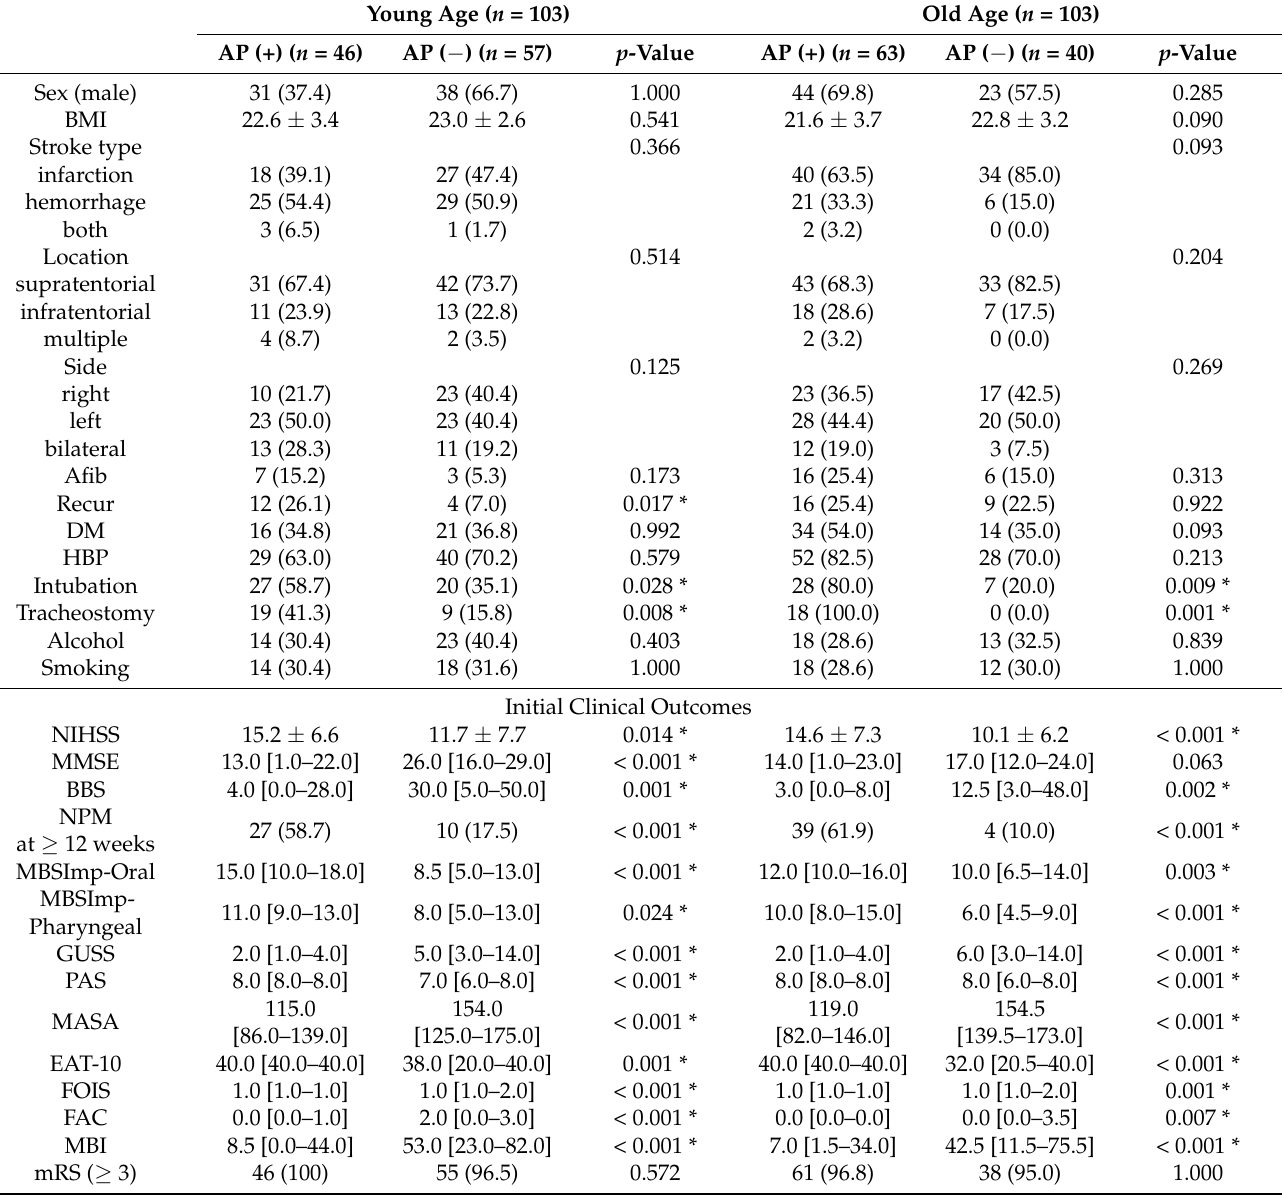
Table 1. Baseline characteristics of the participants, according to age and aspiration pneumonia history. Young Age ( n =